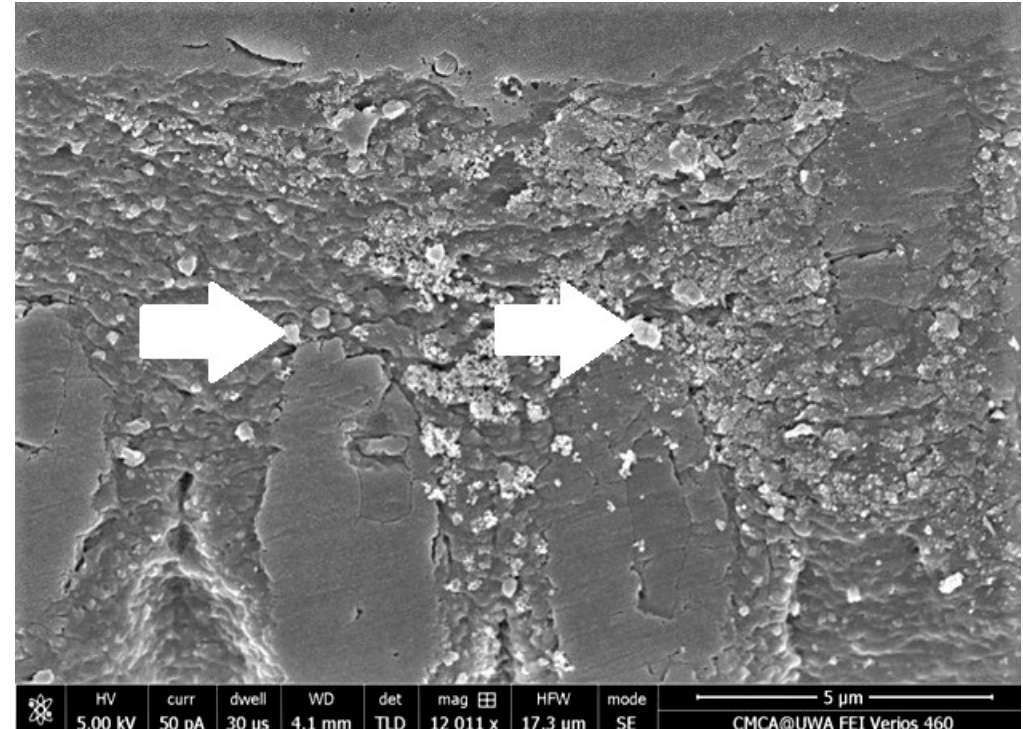
Figure 5. SEM micrograph of the hybrid layer showing widely distributed opaque HA nanoparticles (arrows). Reprinted with permission from Al-Hamdan et al. [33]. Copyright 2020 MDPI.